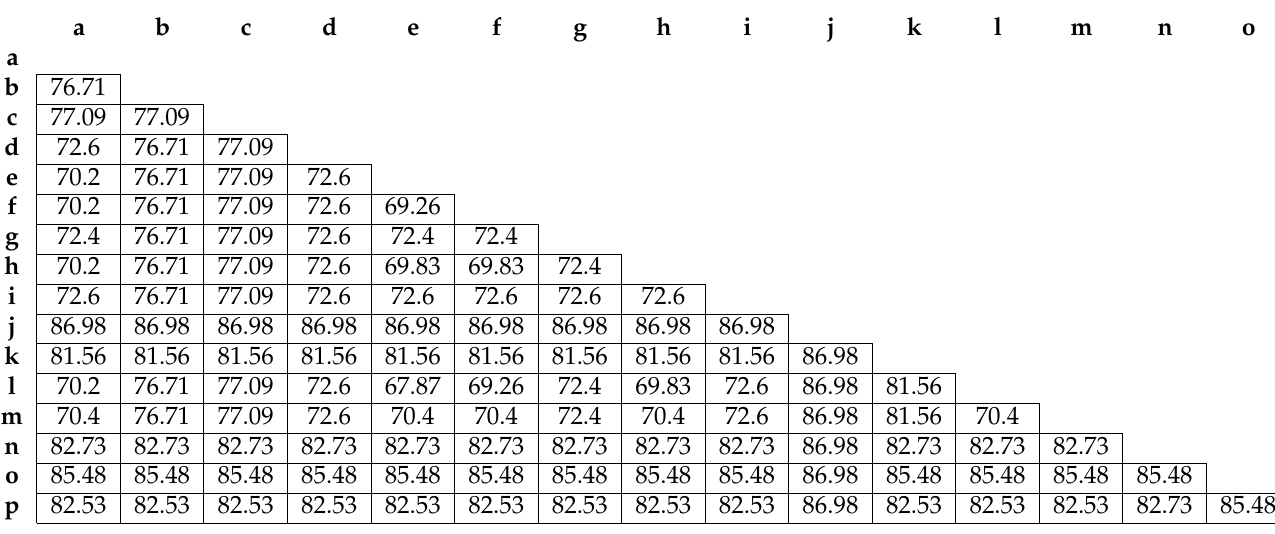
Table 5. RSSI values for reader–antenna combinations.